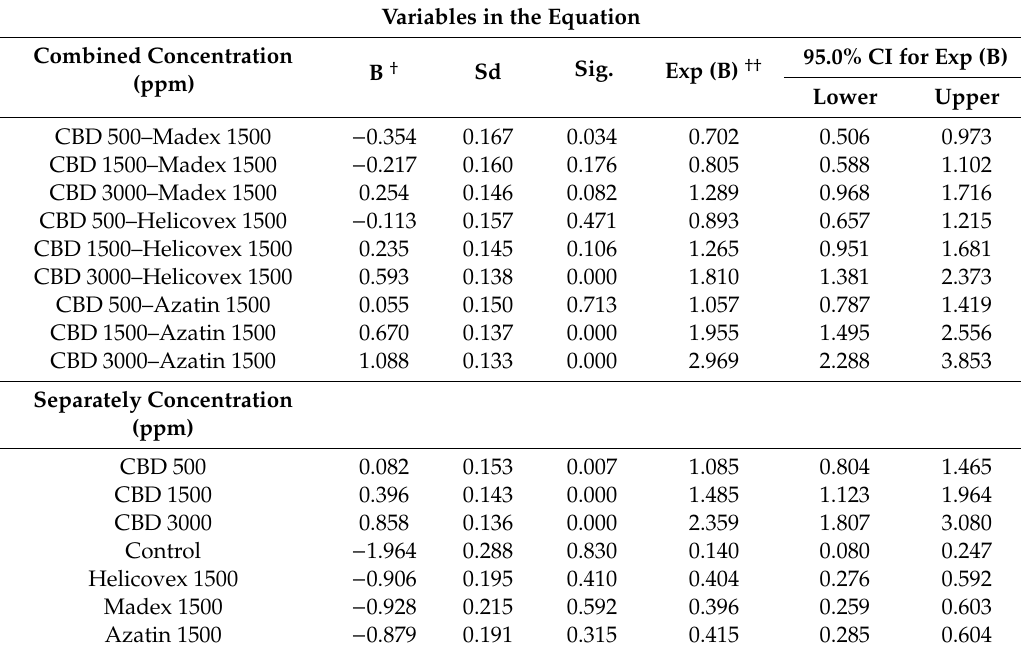
Table 4. Toxicity variables in the equation from Cox regression for the treatments against S. zeamais , R. dominica , P. truncatus and T. granarium adults at the end of Table. 28 days. † B: B values are associated with increased hazard and decreased survival time; as the predictor increases, the hazard of the event increases and the predicted survival duration decreases. Negative coe ffi cients indicate decreased hazard and increased survival times. †† Exp (B): the ratio of hazard